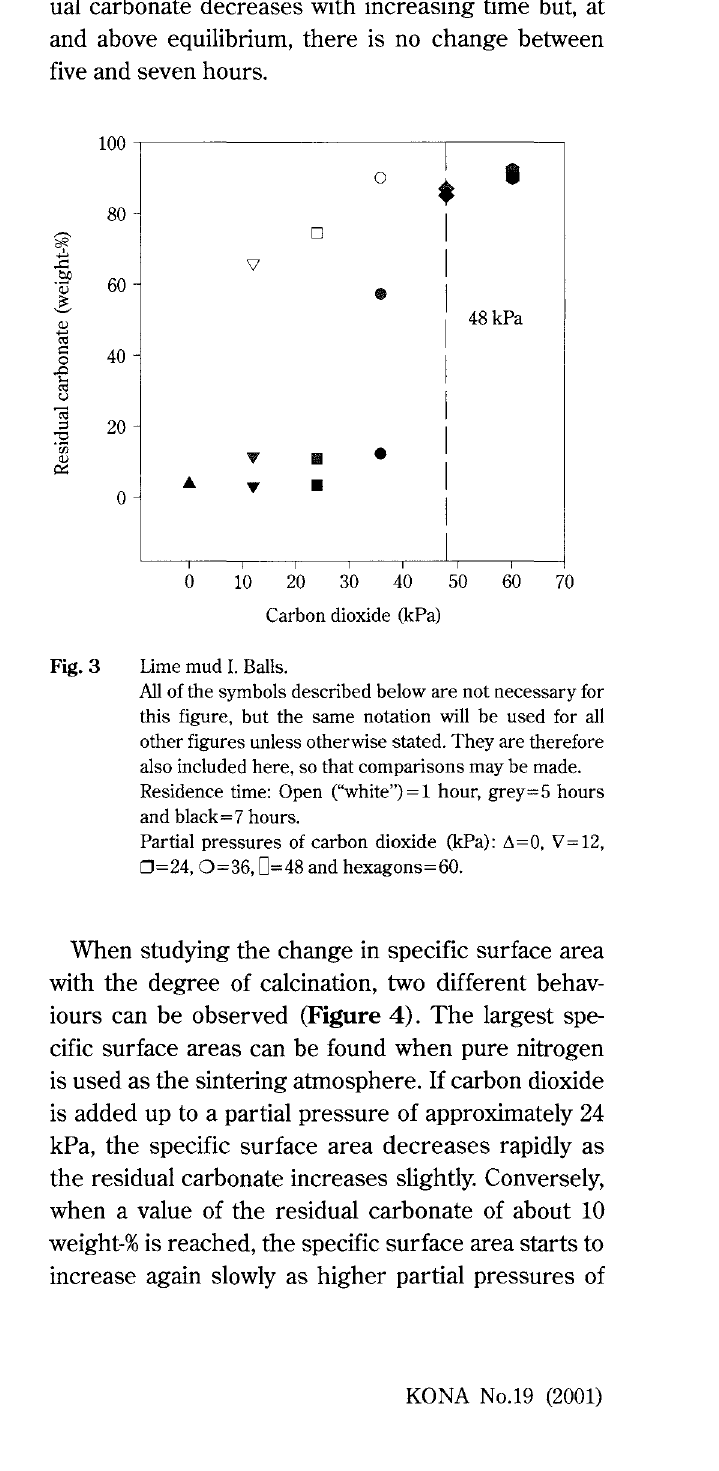
Lime mud I. Balls. All of the symbols described below are not necessary for this figure, but the same notation will be used for all other figures unless otherwise stated. They are therefore also included here, so that comparisons may be made. Residence time: Open ("white")= 1 hour, grey= 5 hours and black=7